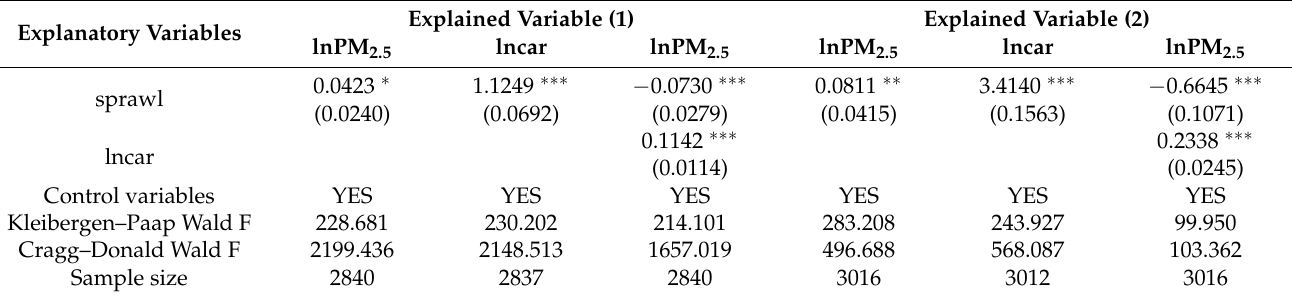
Table 5. Empirical results of instrumental